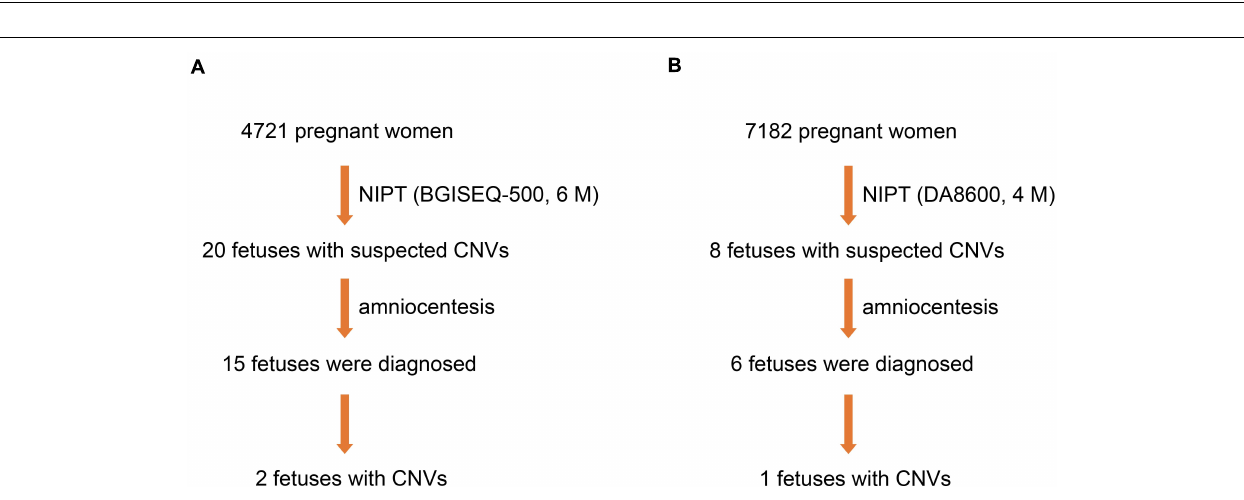
FIGURE 1 | Basic information of enrolled patients. (A) Density curve of gestational weeks. (B) Sankey diagram of demographic details.